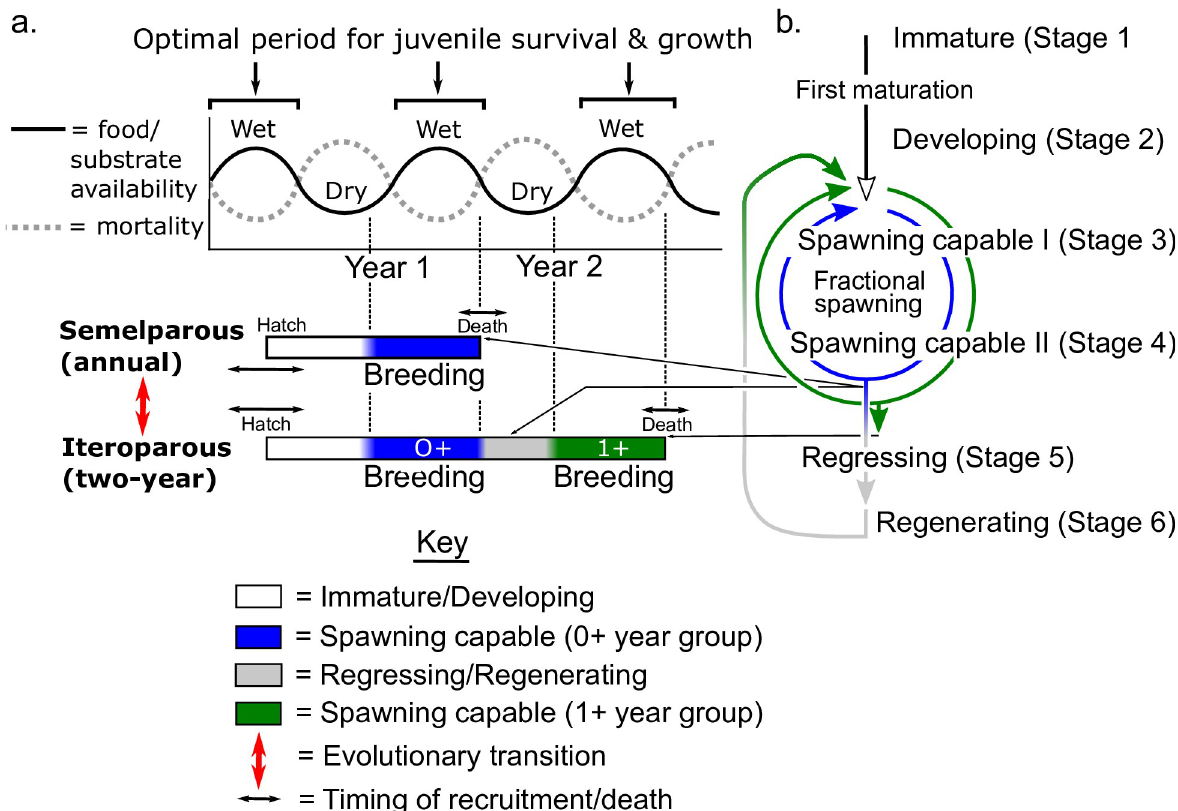
Fig 12. Summary conceptual models of semelparous (annual) and iteroparous (two-year) life histories as alternative evolutionarily stable strategies in seasonally variable Amazonian habitats. a. Seasonal variation in predator-induced mortality and food/substrate availability is expected to drive an adaptive pattern of reproduction during a single prolonged annual breeding season period, corresponding to the wet season (= rainy season/high water) period of optimal survival and juvenile growth. During the breeding period, females reproduce in multiple fractional spawning events. Species with iteroparous two-year lifespans add an additional year to their lifespan and delay post-reproductive mortality from the end of the 0+ year group to the end of a second, 1+ year group. Evolutionary transitions between semelparity and iteroparity do not appear to be correlated to habitat (floodplain versus terra firme streams) in upper Amazon Brachyhypopomus . The iteroparous species B . beebei exhibits a pattern of reproductive restraint in the 0+ year group relative to the 1+ year group consistent with terminal reproductive investment. Reproductive restraint in the 0+ group may increase the probability of survival through the dry-season period of elevated mortality (individuals that survive to the 1+ year group are expected to benefit from increased fecundity and mating success than 0+ individuals). Note: life spans of both semelparous and iteroparous species likely exhibit variation related to the time of recruitment and death (see horizontal double arrow lines). b. Conceptual model of reproductive maturational stages, adapted from Brown-Peterson et al. [48], showing cyclical progression of maturational stages for a 0+ year group (of annual semelparous and two-year iteroparous species) in blue, and a 1+ year group (for two-year iteroparous species only) in green. Spawning capable (Stage 3 and 4) females cycle back and forth (see circular arrows) between Stage 3 (subphase I–not actively spawning) and Stage 4 (subphase II–actively spawning) as successive batches of oocytes are released in fractional spawning events, each of which lasts several nights.